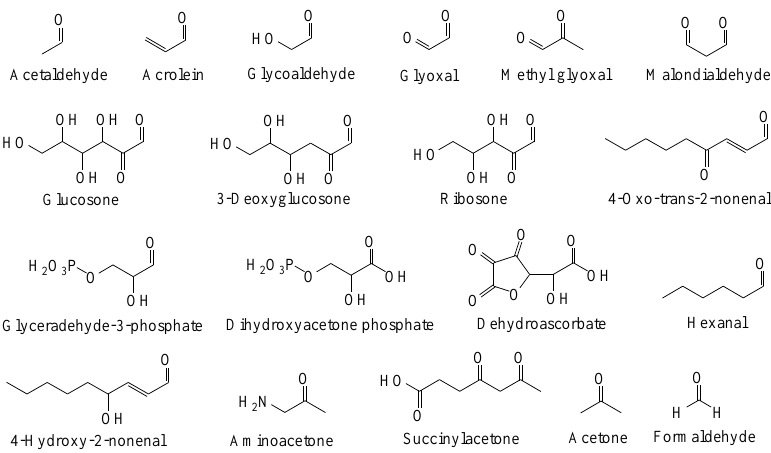
Figure 1. Chemical structure of commonly found RCS.